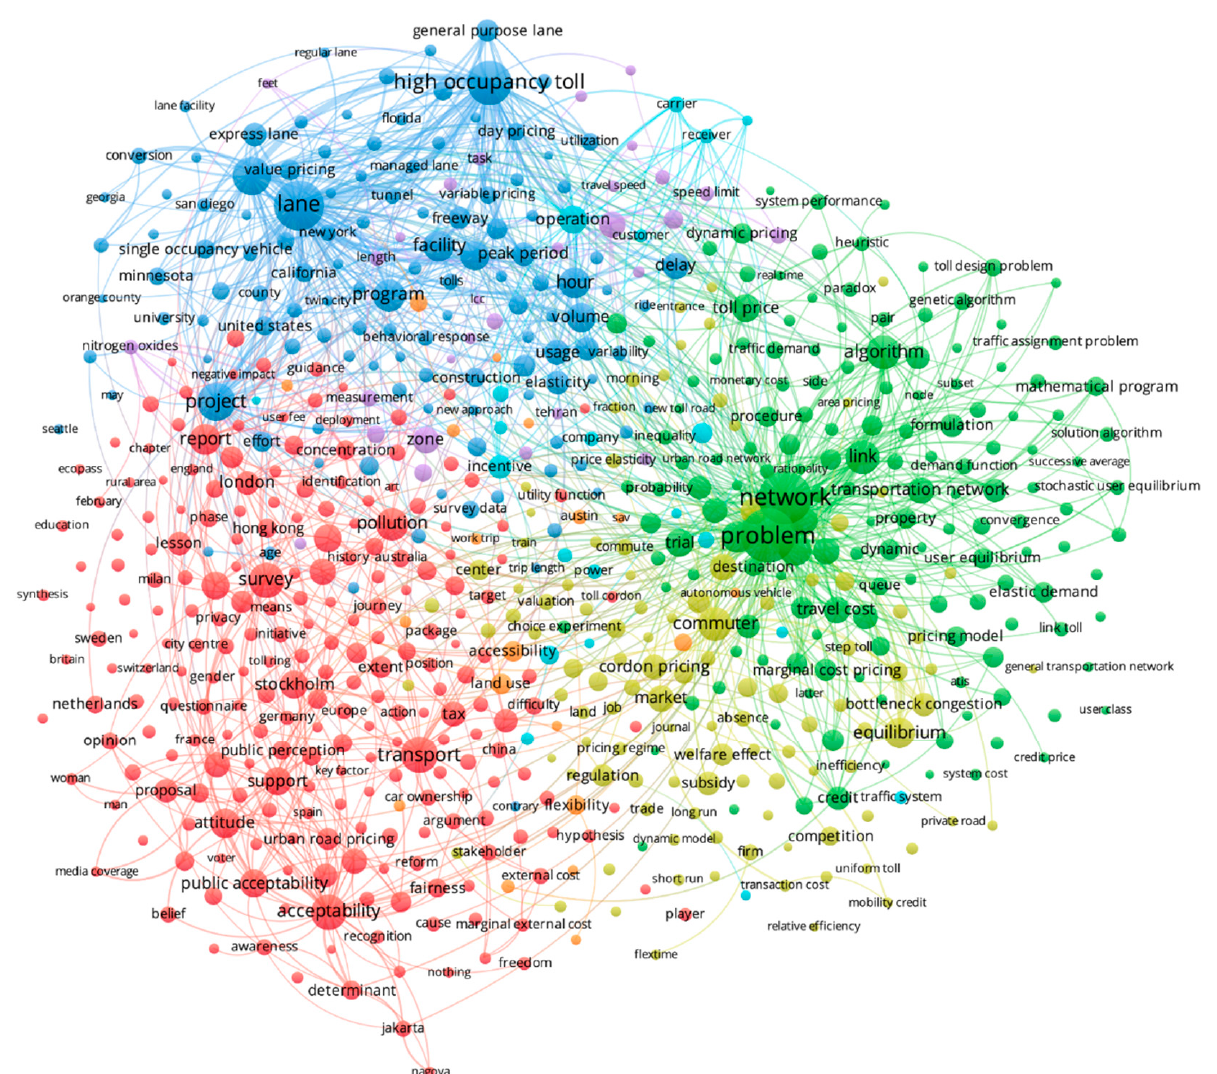
Figure 3. Title and abstract terms in congestion pricing bibliometric review.